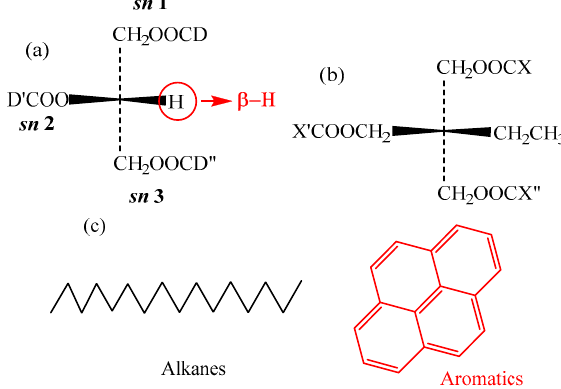
Figure 2. Molecular geometry of different insulation oil: ( a ) Natural ester insulation oil; ( b ) trimethylolpropane triester; ( c ) mineral oil.